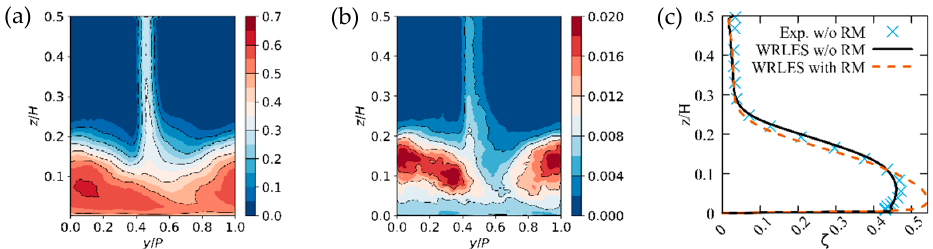
Figure 16. Effect of relative motion downstream of the blade (plane at x/C = 0.89 ). Cutplane of ( a ) total pressure and ( b ) TKE. In these two figures, the pitch is normalized by cascade pitch P and its origin such that the wake appears in the centre. ( c ) Pitchwise averaged total pressure losses. Experimental data from Krug et al. [23].